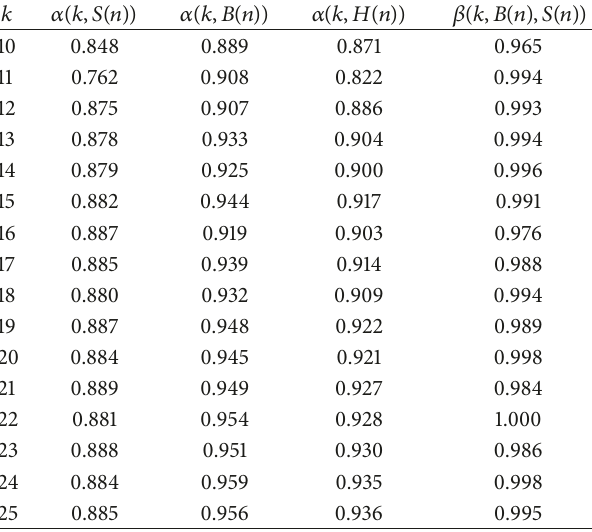
Figure 5: Hofstadter Chaotic Heart sequence with 𝐶(𝑛) − 𝑛/2 over- laid. Table 2: The values of 𝛼(𝑘,𝑆(𝑛)) , 𝛼(𝑘, 𝐵(𝑛)) , 𝛼(𝑘,𝐻(𝑛)) , and 𝛽(𝑘,𝐵(𝑛),𝑆(𝑛)) for Maternal Spot Generation intervals on the 𝑄 -